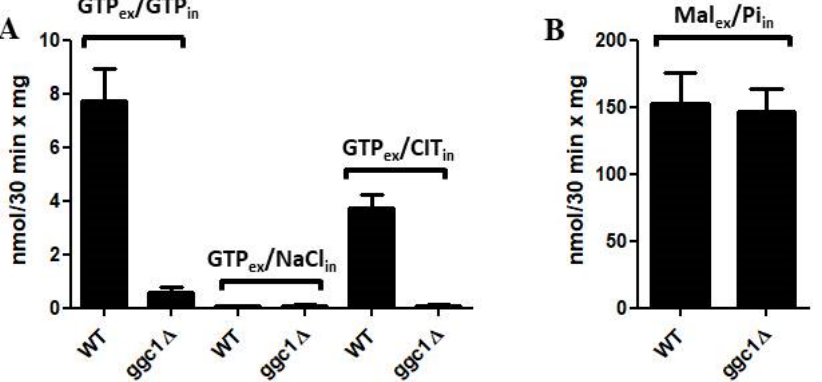
Figure 8. GTP/GTP, GTP/NaCl and GTP/citrate ( A ) and malate/Pi ( B ) transport activities in liposomes reconstituted with wild-type or ggc1 ∆ mitochondrial extracts. Transport was started by adding 1 µ M [8- 3 H] GTP ( A ) and 0.1 mM [ 14 C] malate ( B ) to proteoliposomes preloaded with 5 mM GTP, 5 mM NaCl or 5 mM citrate ( A ) and 20 mM Pi ( B ). The values are the means ± SD of four